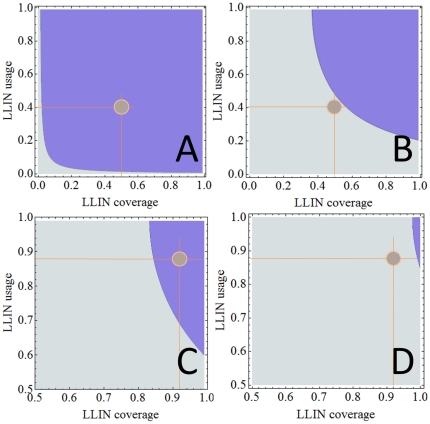
Basic reproduction numbers (R0).Basic reproductive numbers (R0) for all values of LLIN coverage and usage for M1 (Panel A) and M2 (Panel B) in the low transmission setting and M1 (Panel C) and M2 (Panel D) in the high transmission setting. Light blue areas denote R0>1 and dark blue areas denote R0<1. The light brown circles denote the scenarios explicitly shown in Figure 2. Note that R0 = 1 sets apart ‘sustained transmission’ from ‘malaria eradication’. It can clearly be seen that in Panels A and C (M1) R0 is well below this discriminating value of 1. In Panels B and D (M2) the values for R0 are clearly below the value of 1. Therefore, while M1 predicts malaria eradication, M2 still predict persistent transmission.